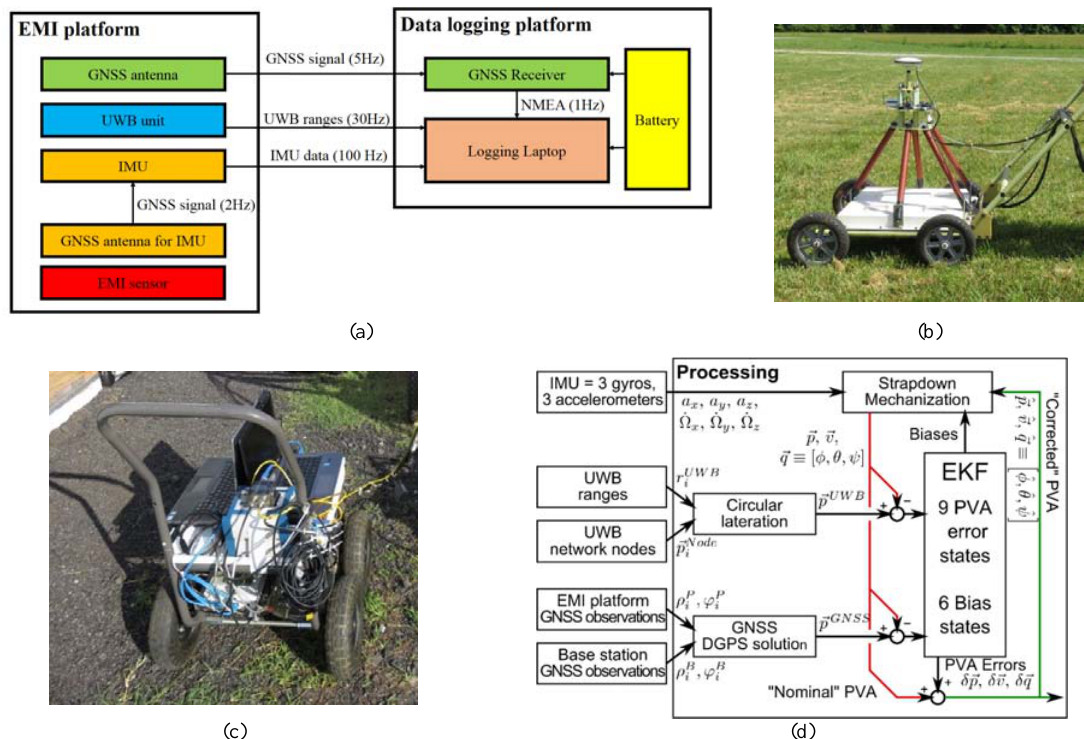
Figure 3. System hardware components (a), the EMI sensor platform (b), data logging platform (c), and the data processing workflow including the error state Extended Kalman Filter